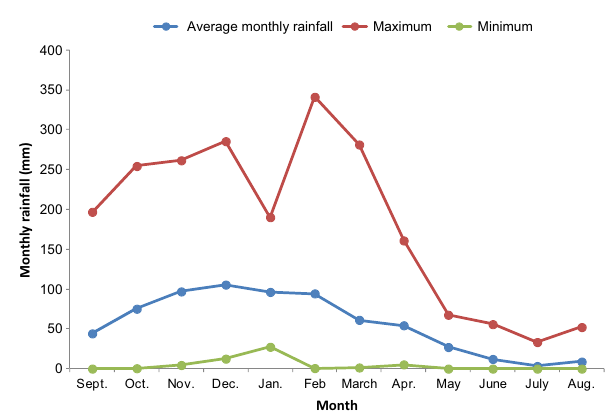
Fig. 2 Evolution of the monthly rainfall at Ghèzala Dam station